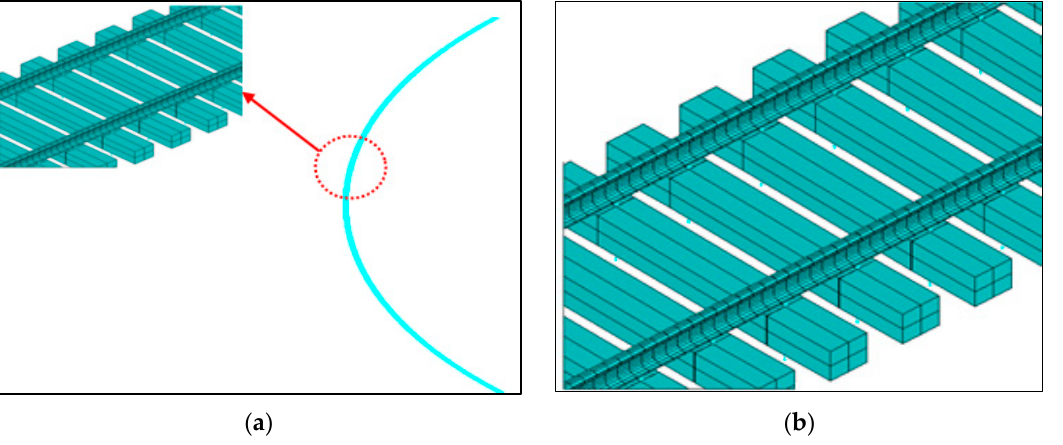
Figure 8. FE model of CWR track ( a ) Whole model; ( b )FE model details of CWR track. Table 2. Component properties of FE model of CWR track.